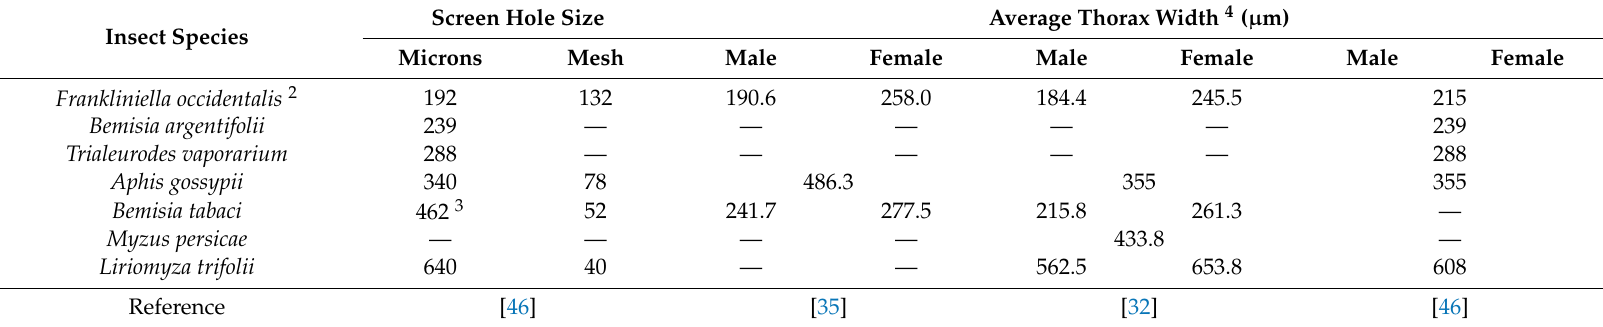
Table 1. Hypothetical exclusion e ffi ciency 1 of insect nets for the control of a designated pest, hole size, and mesh number of widespread insect nets and average thorax width of “key